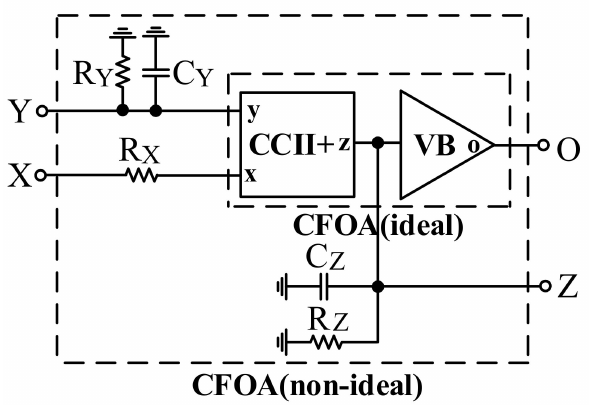
Figure 5. General equivalent circuit of the non-ideal CFOA.